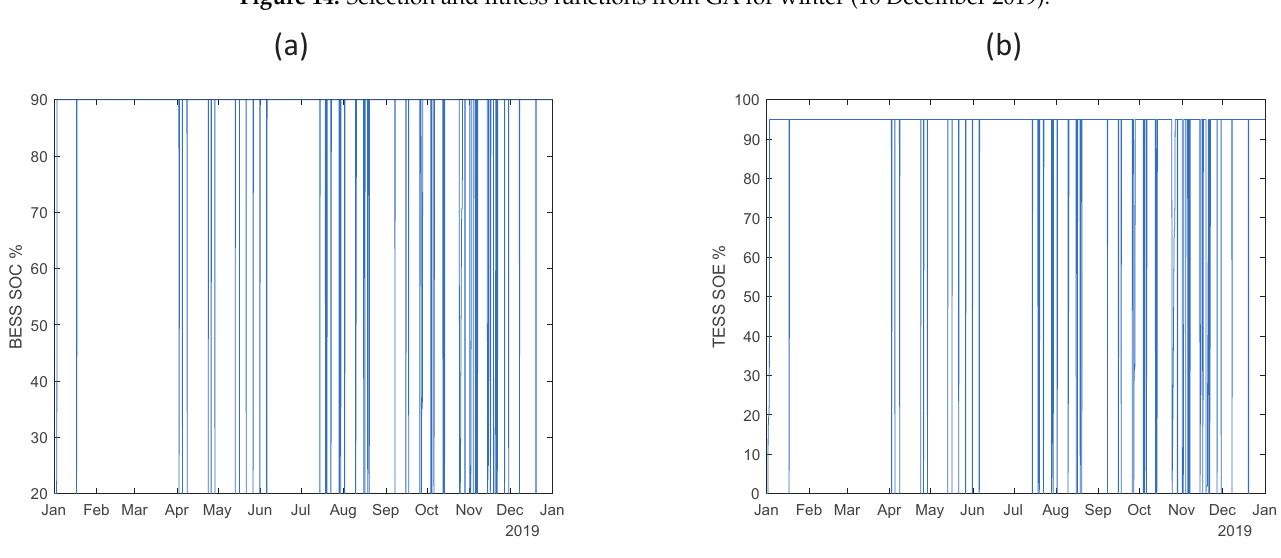
(cid:3) Figure 14. Selection and fitness functions from GA for winter (16 December 2019).